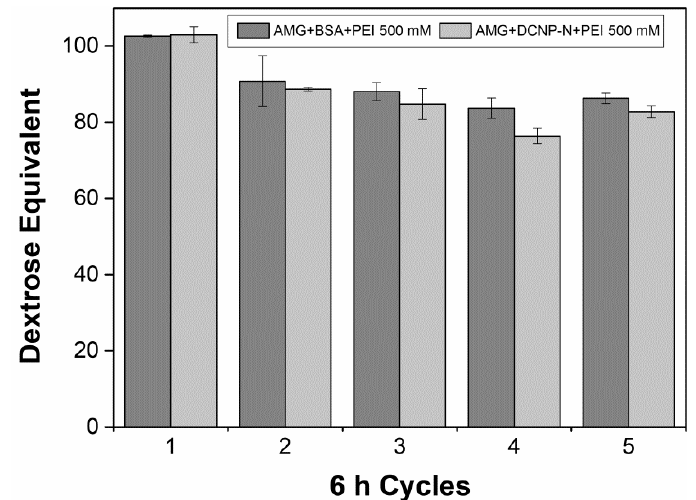
Figure 16. Hydrolysis of pre-hydrolyzed starch with α-amylase (35%, w / v ) catalyzed by CLEAs of amyloglucosidase (AMG) prepared by enzyme treatment with polyethyleneimine (PEI) and by co- aggregation with the magnetic nanoparticles DCNP-N or bovine serum albumin (BSA) at 45 °C and pH 4.5 for 6 h reaction. Values are shown as the mean of duplicate experiments ± s.d.